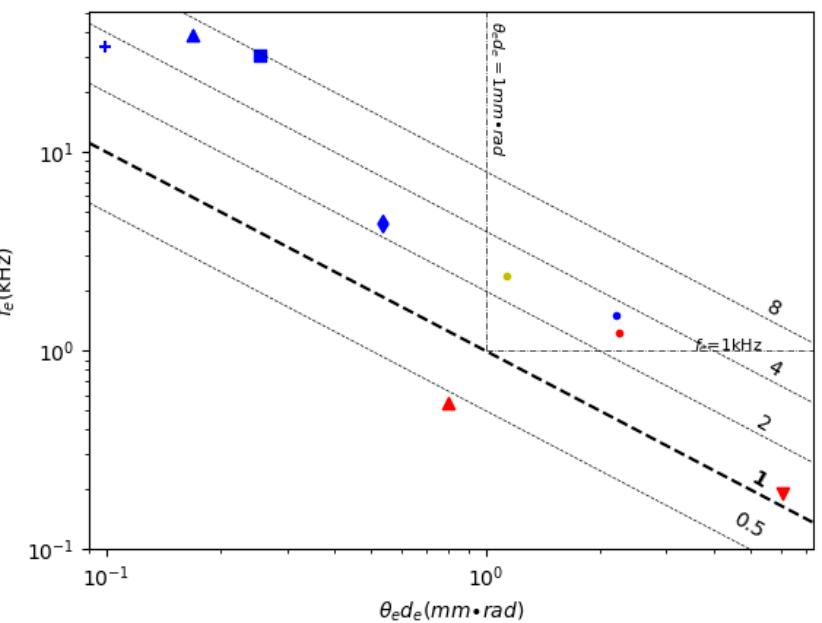
Figure 5. A comparison of 1D resonant scanning MEMS mirrors (The markers are listed in the table above. The same as below.).